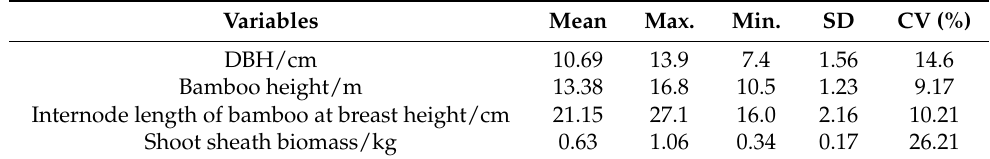
Figure 2. Distribution of diameter classes of new bamboo trees. Table 1. The descriptive statistics of Moso bamboo shoot sheath biomass modeling samples.